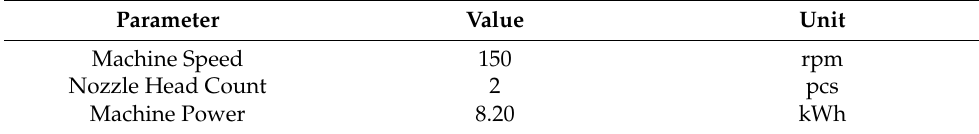
Table 1. Norden NML-150 tube filling machine specification [20].